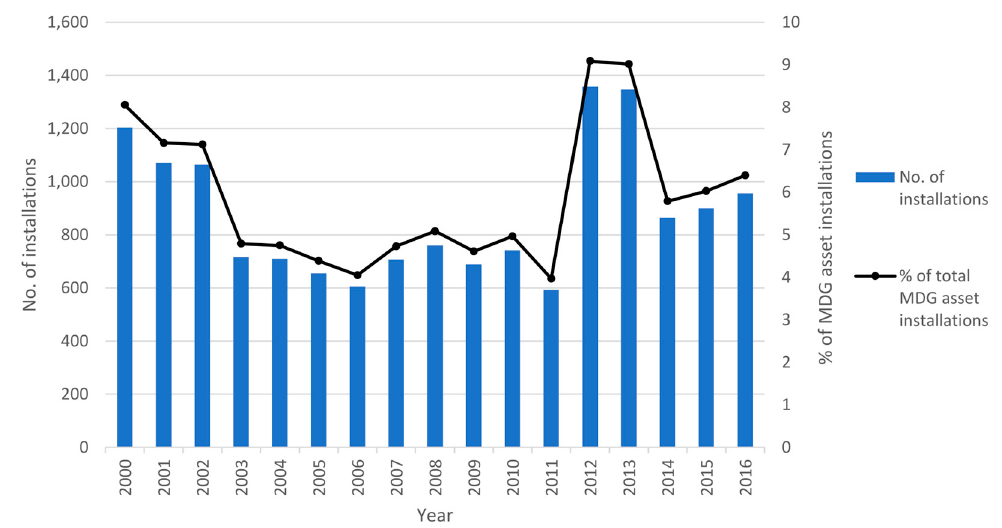
Figure 2. Trend of Afridev hand pump borehole installations across Millennium Development Goal (MDG) key dates in Malawi (n = 14,943).